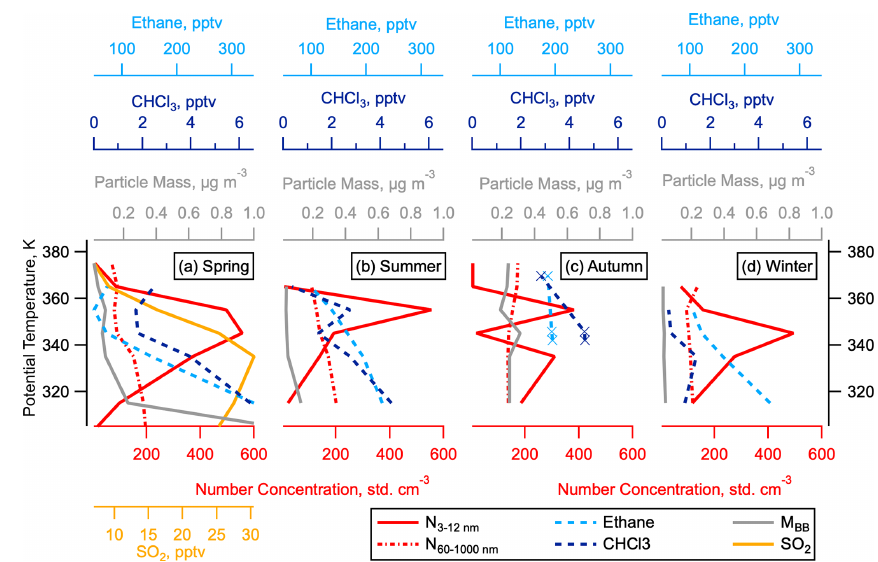
Figure 10. Vertical Profiles of nucleation mode particles and tropospheric tracers in the NH LMS. The 50th percentiles of number concentra- tions of nucleation mode (3–12nm) and accumulation mode (60–1000nm) particles, mass concentration of particles from biomass burning ( M BB ), and concentrations of ethane and chloroform (CHCl 3 ), as a function of potential temperature in the NH LMS. The 50th percentile of the measured SO 2 concentration is given in spring only, as these measurements were not taken in other